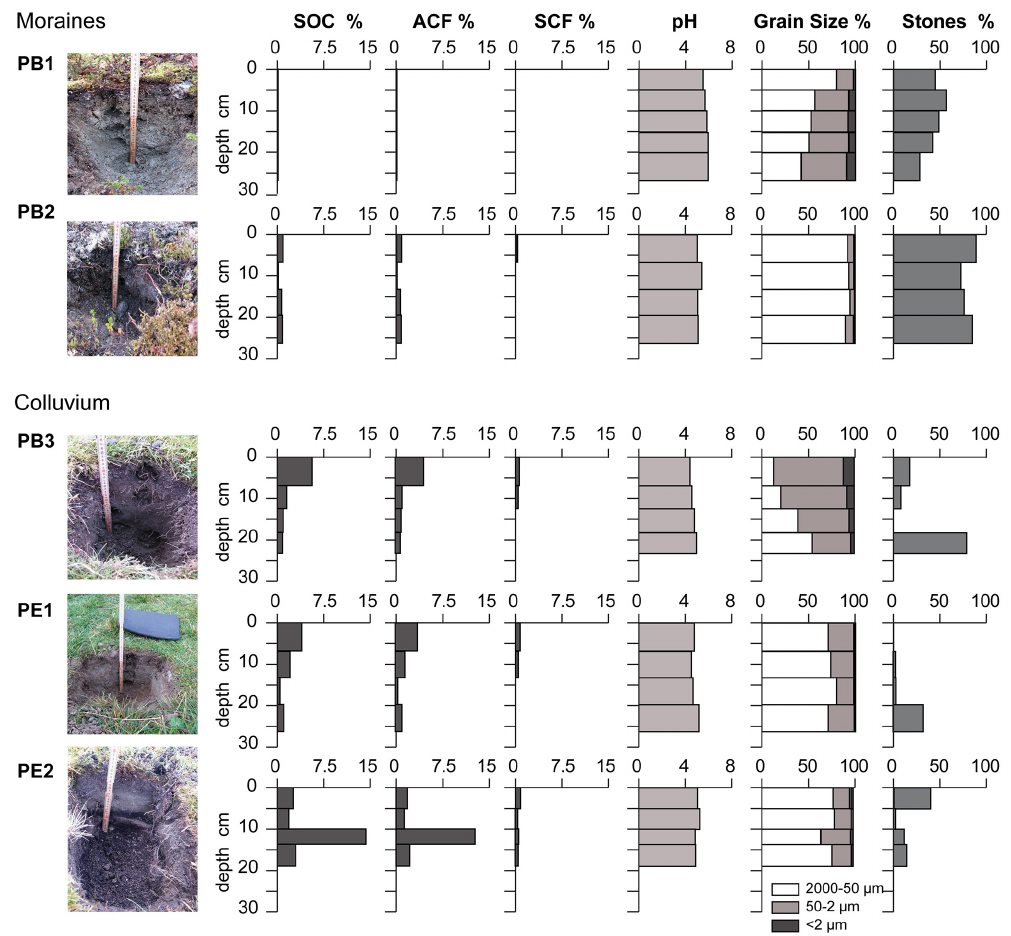
Figure 4. The study profiles on the Leptosols of the moraines and the Regosols of the colluvium and the depth distribution of main soil